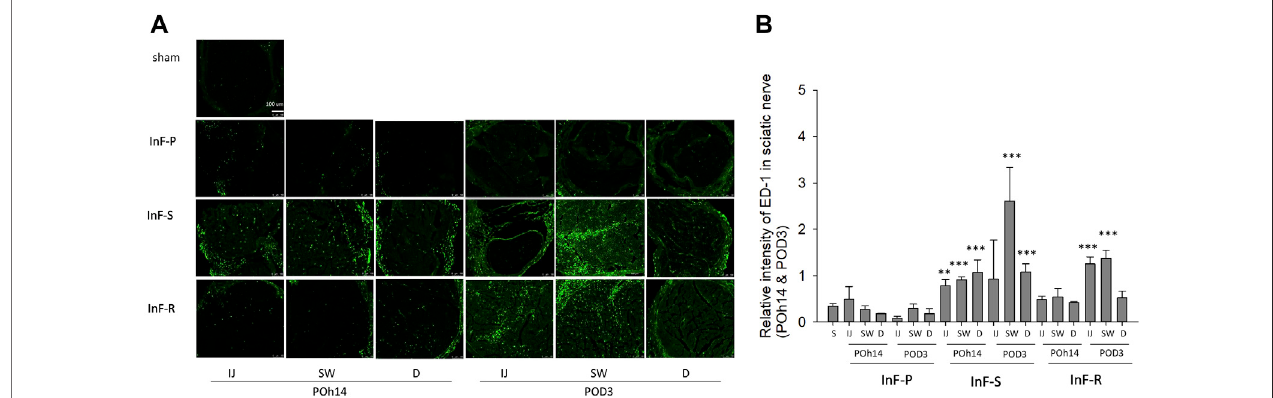
FIGURE 4 | Intrafascicular saline/ropivacaine injection into sciatic nerve increased macrophage in fi ltration (A) Representative immuno fl uorescent images and (B) quanti fi cation of ED-1(+) in fi ltrating macrophage in the three distinct cross-sections of sciatic nerves were showed. Intrafascicular saline (InF-S) injection demonstrated more in fi ltrating macrophage in the sciatic nerve versus the sham group at POh14 and POD3. Whereas only the IJ and SW sites of sciatic nerve from intrafascicular ropivacaine(InF-R)injectiongrouponPOD3signi fi cantlyincreasedED-1(+)macrophageswasfound.POD,post-operation-day;injectionsite(IJ),swollensite(SW), distal site (D) of sciatic nerve. Needle pierce sciatic nerve only (InF-P). Group differences were compared by Mann – Whitney U -test. Error bars represent SE. *** p < 0.001, ** p < 0.01. scale bar, 100